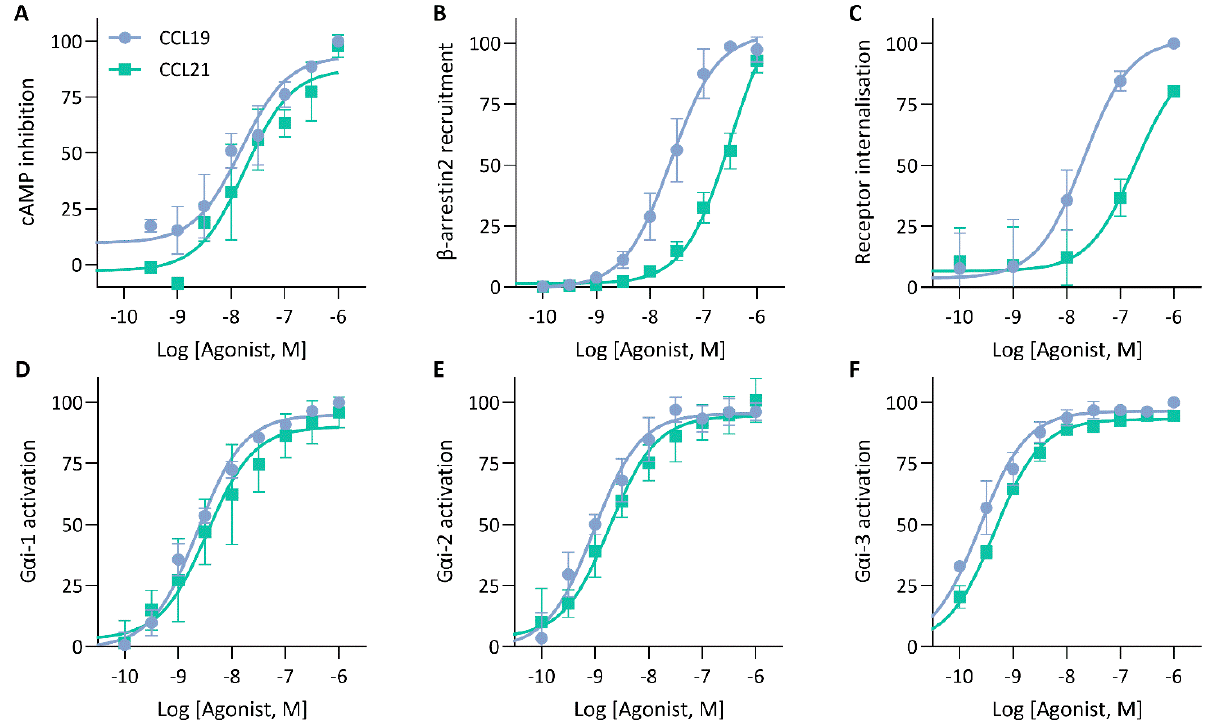
Figure 4. cAMP inhibition, G protein activation and β -arrestin recruitment by CCR7. ( A ) Analysis of ligand-mediated inhibition of forskolin-induced cyclic adenosine monophosphate (cAMP) production. CCR7-expressing HEK293 cells transiently transfected with a pGloSensor-22F were exposed to increasing concentrations of CCL19 or CCL21 and changes in bioluminescence were monitored ( B ) Measurement of β -arrestin2 recruitment to CCR7. HEK293 cells were transiently transfected with CCR7-LgBiT and β -arrestin2-SmBiT to monitor the recruitment of β -arrestin2 to CCR7 following CCL19 or CCL21 stimulation ( C ) Ligand-induced CCR7 internalisation. CCR7 was stained using a PE-labelled anti-CCR7 antibody and CCR7-fluorescent signal was monitored using flow cytometry and compared to an unstimulated control. ( D , E ) Assessment of G protein activation by CCR7. HEK293 cells stably expressing CCR7 were transiently co-transfected with ( D ) G α i1-91-NLuc, ( E ) G α i2-91-NLuc or ( F ) G α i3-91-NLuc and G γ 2-LSS-mKATE2. G protein dissociation was monitored following stimulation with CCL19 or CCL21. ( A – F ) Data were scaled with the AUC (or median ( C )) of the maximal CCL19 response set to 100 %. Data are represented as the mean and SD of three (or four ( B )) independent experiments with each three (or one ( C )) technical replicates. Curves were fitted to a three-parametric non-linear regression model.